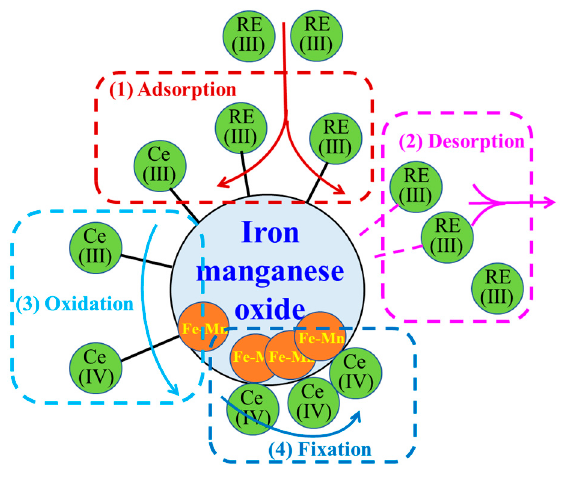
Figure 8. Process of cerium fi xation by iron–manganese oxide.